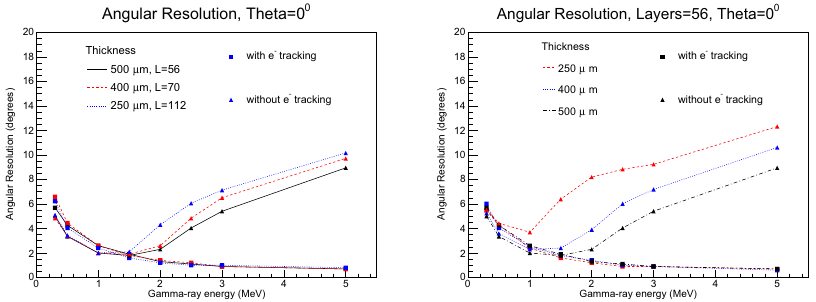
Figure 3: Angular resolution from the reconstruction of Compton events, Left panel: Fix the radiation length. Right panel: Fix the number of